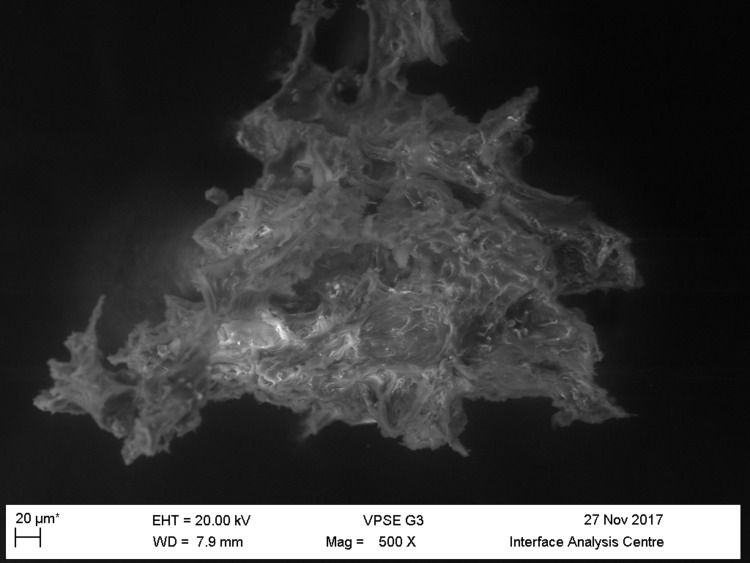
Demineralised Pleistocene-Holocene shark tooth (image 1).